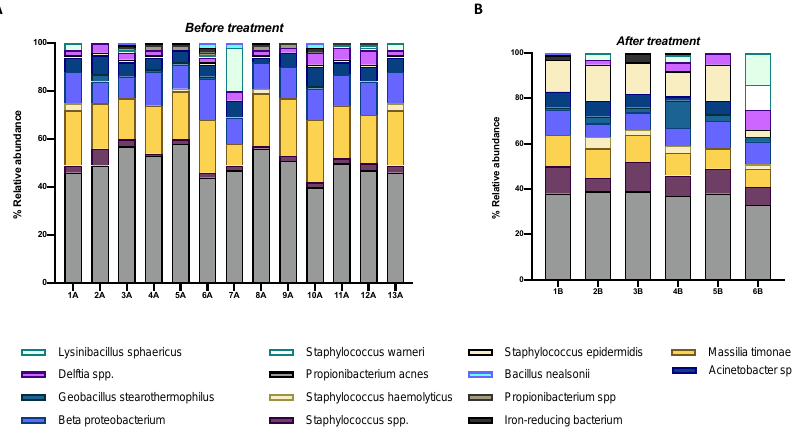
Figure 3. Distribution of relative species abundance in conjunctival swabs before ( A ) and after ( B ) prophylaxis with gentamicin ( p -value < 0.0001).